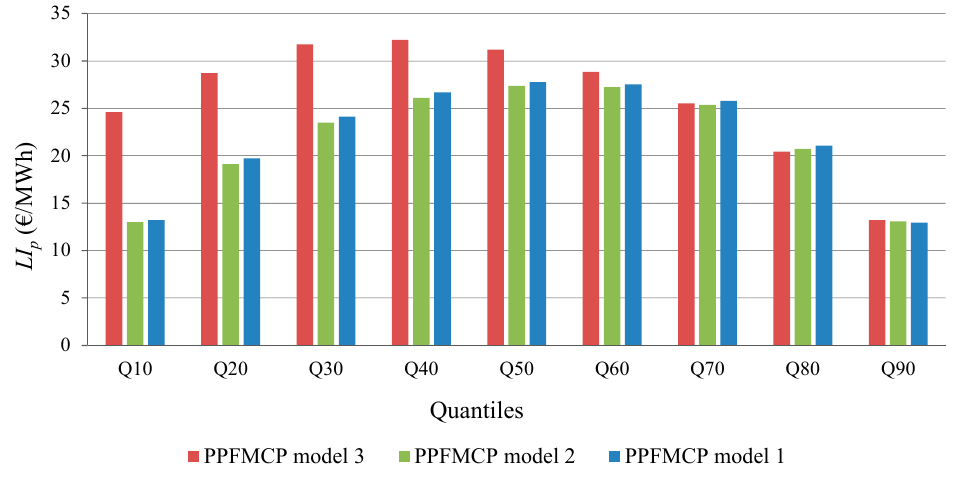
Figure 12. Loss function Indicator for each quantile.